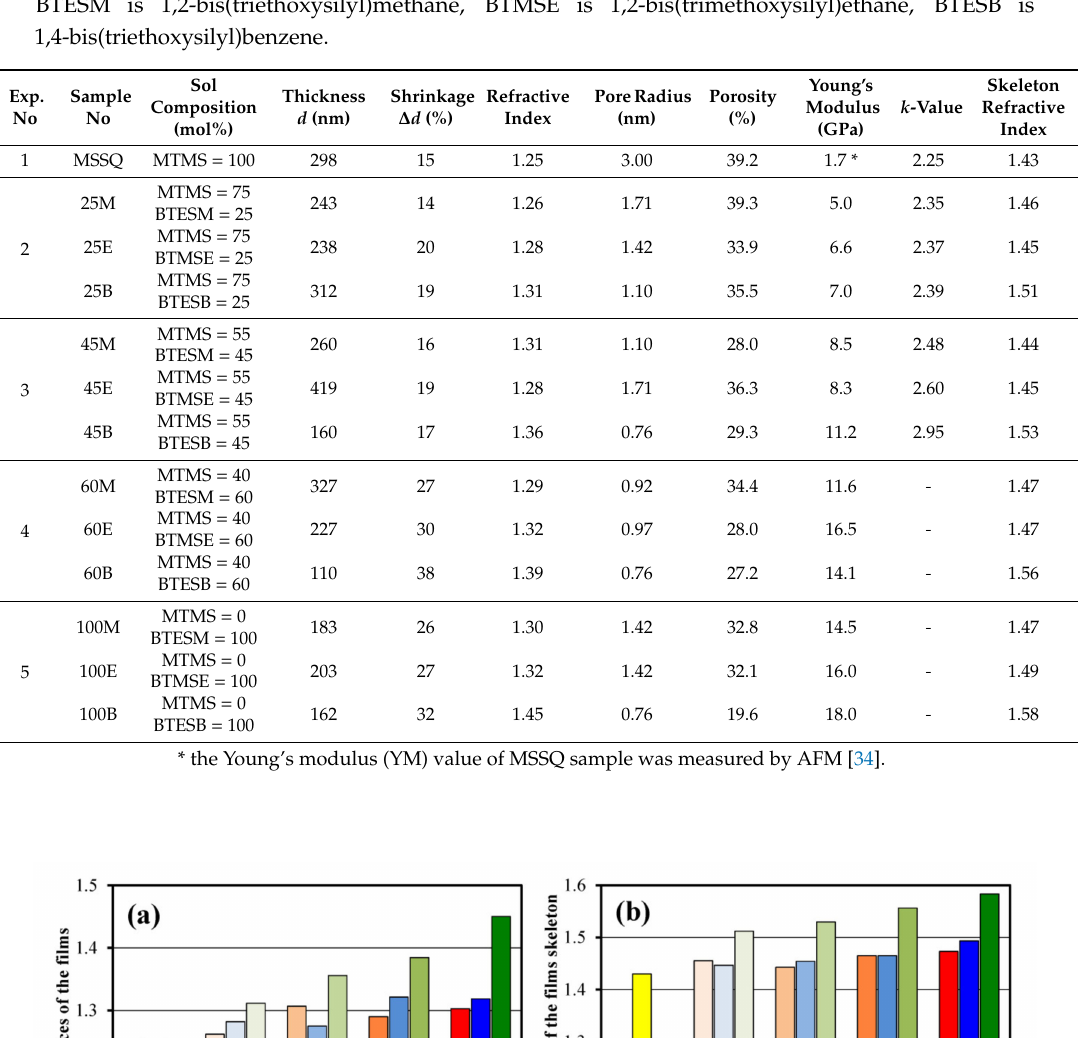
Table 1. Characteristics of porous methylsilsesquioxane film (MSSQ) and organosilicate glass films with different types (M—methylene, E—ethylene, B—1,4-phenylene) and content (0–100 mol%) of bridging groups, annealed at 430 ◦ C for 30 min in air (hard bake). In this Table: MTMS is methyltrimethoxysilane,